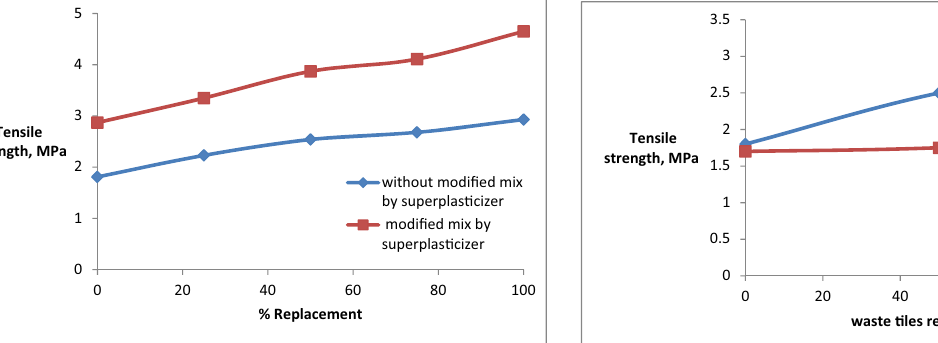
Figure 14: Tensile strength development due to waste tiles repla - cement ( comparison with previous study given in ref. [ 5 ]) .